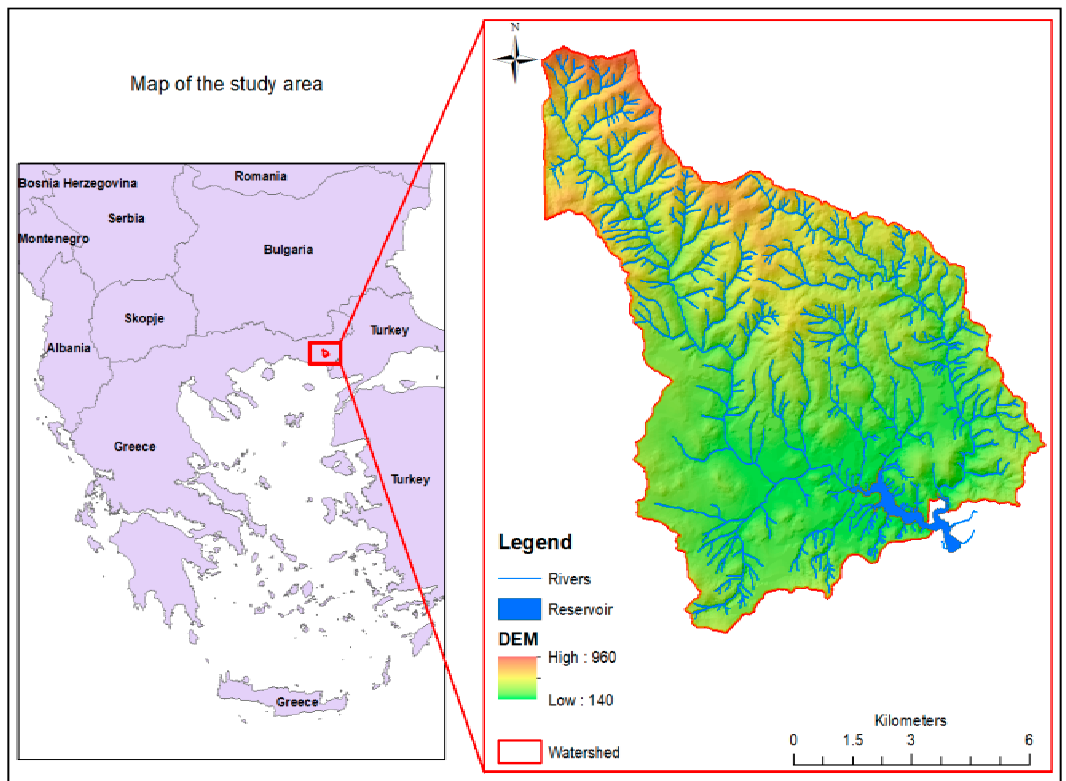
Figure 1. The Nipsa reservoir and the catchment area on the northeast part of Greece.